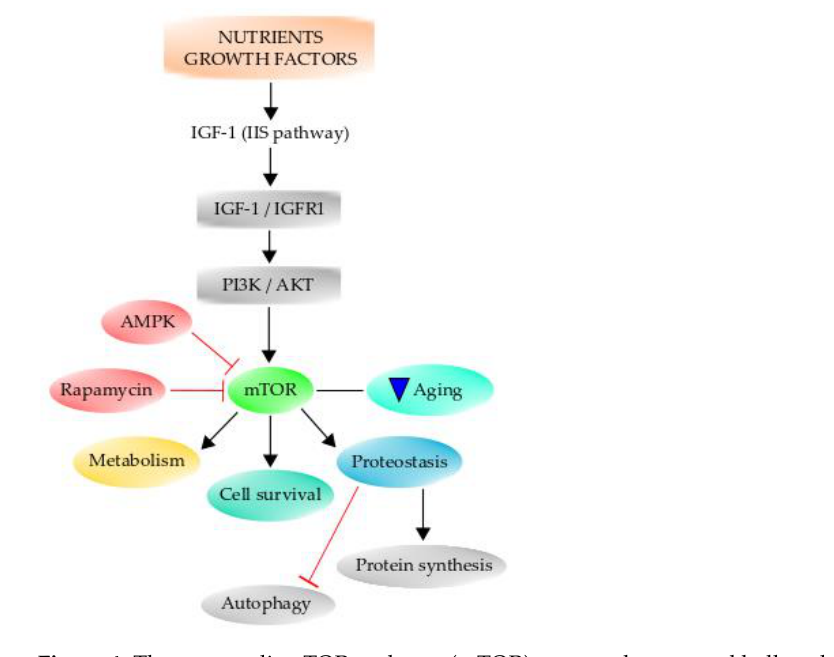
Figure 4. The mammalian TOR pathway (mTOR) can regulate several hallmarks of aging. Growth factors and nutrient availability can activate the IIS pathway to regulate mTOR, which acts on downstream targets, regulating metabolism, cell survival, and proteostasis, among several others. mTOR inhibition by rapamycin or by AMPK can decrease aging. Further, mTOR is able to negatively regulate autophagy and positively regulate protein